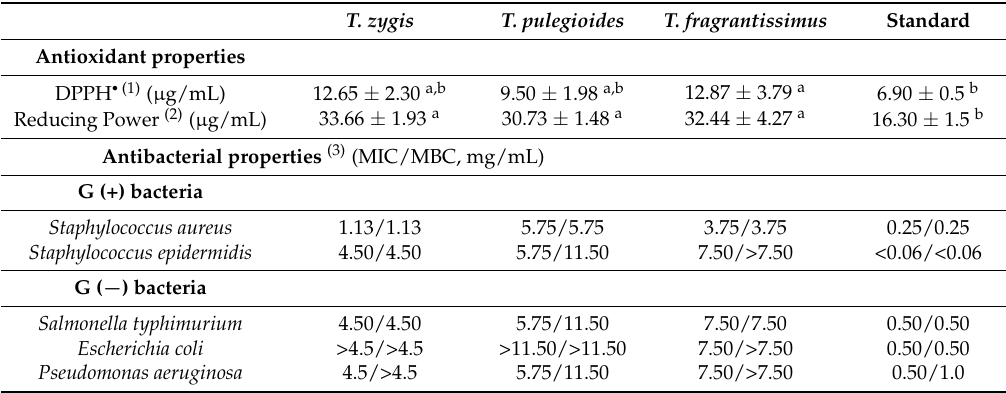
Table 4. Antioxidant and antibacterial properties of aqueous extracts from T. zygis , T. pulegioides and T. fragrantissimus